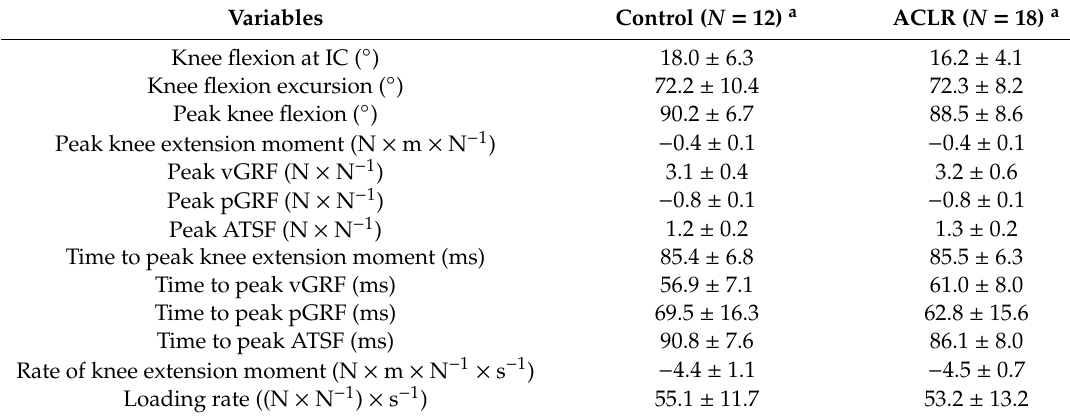
Table 2. Landing biomechanics during double-leg jump landings.